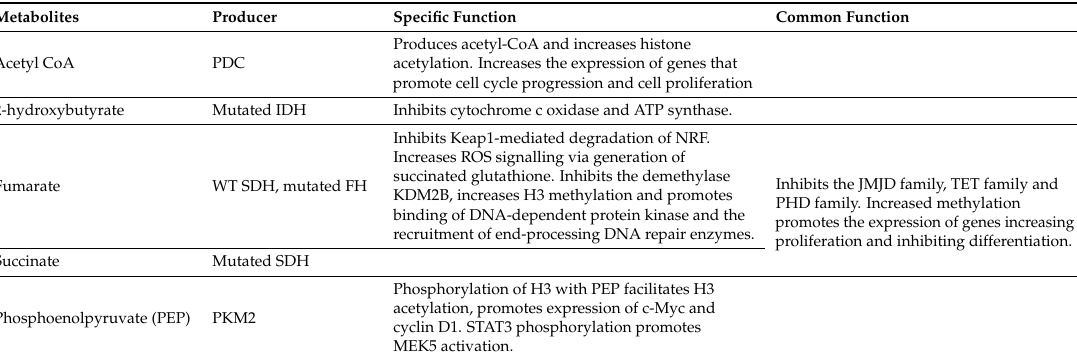
Table 1. Summary of